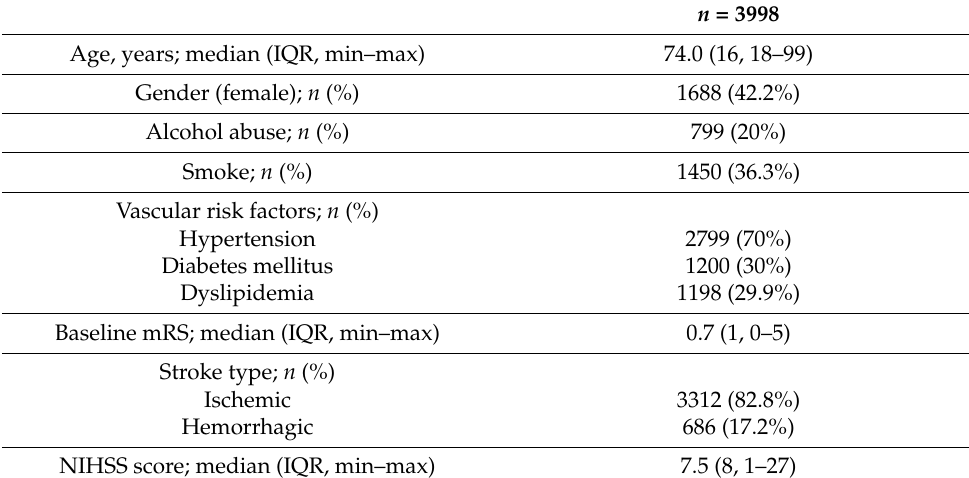
Table 1. Baseline characteristics of whole stroke